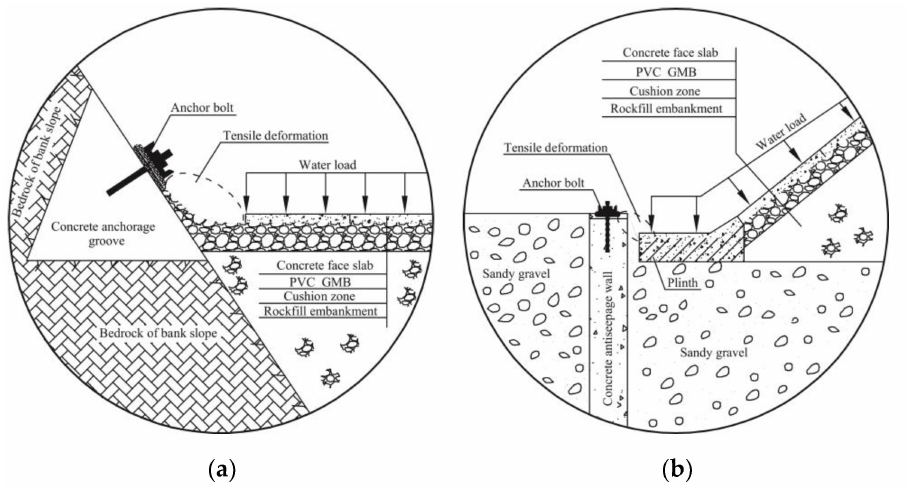
Figure 1. Anchorage of PVC GMBs in MFRD: ( a ) on the plinth of the dam abutment; ( b ) on the top of the concrete antiseepage